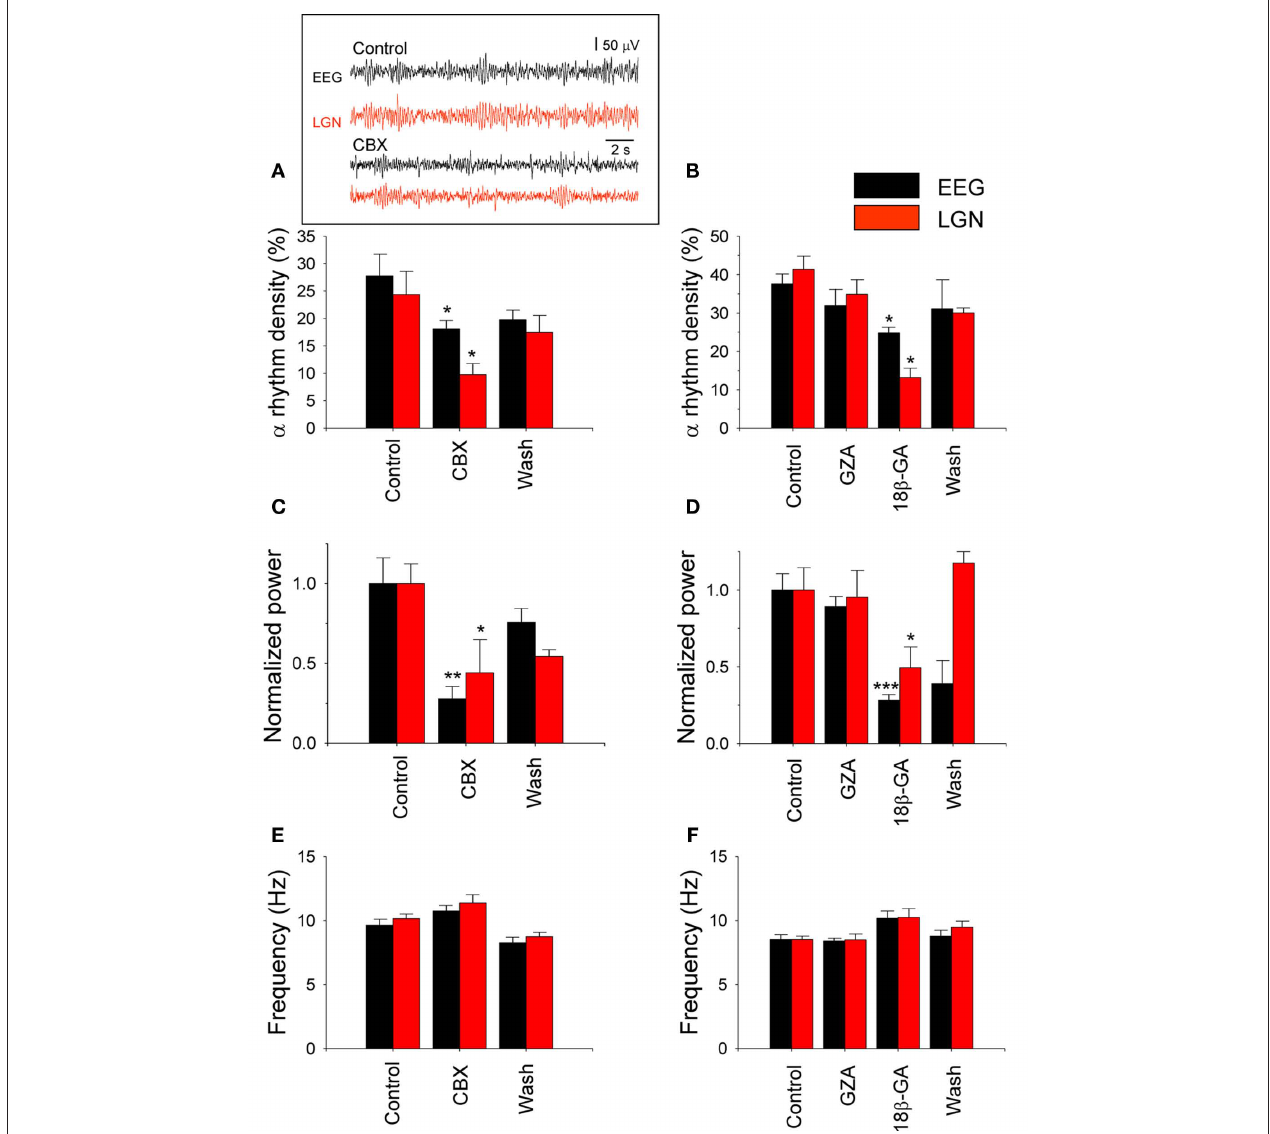
FiGurE 2 | Thalamic delivery of gap junction (GJ) blockers disrupts LGN and EEG a rhythms. (A–F) Bar graphs summarizing the effect of thalamic CBX and GZA/18 β -GA application on EEG (black bars) and LGN (red bars) α rhythm density ( A,B , respectively), normalized power ( C,D , respectively), and frequency